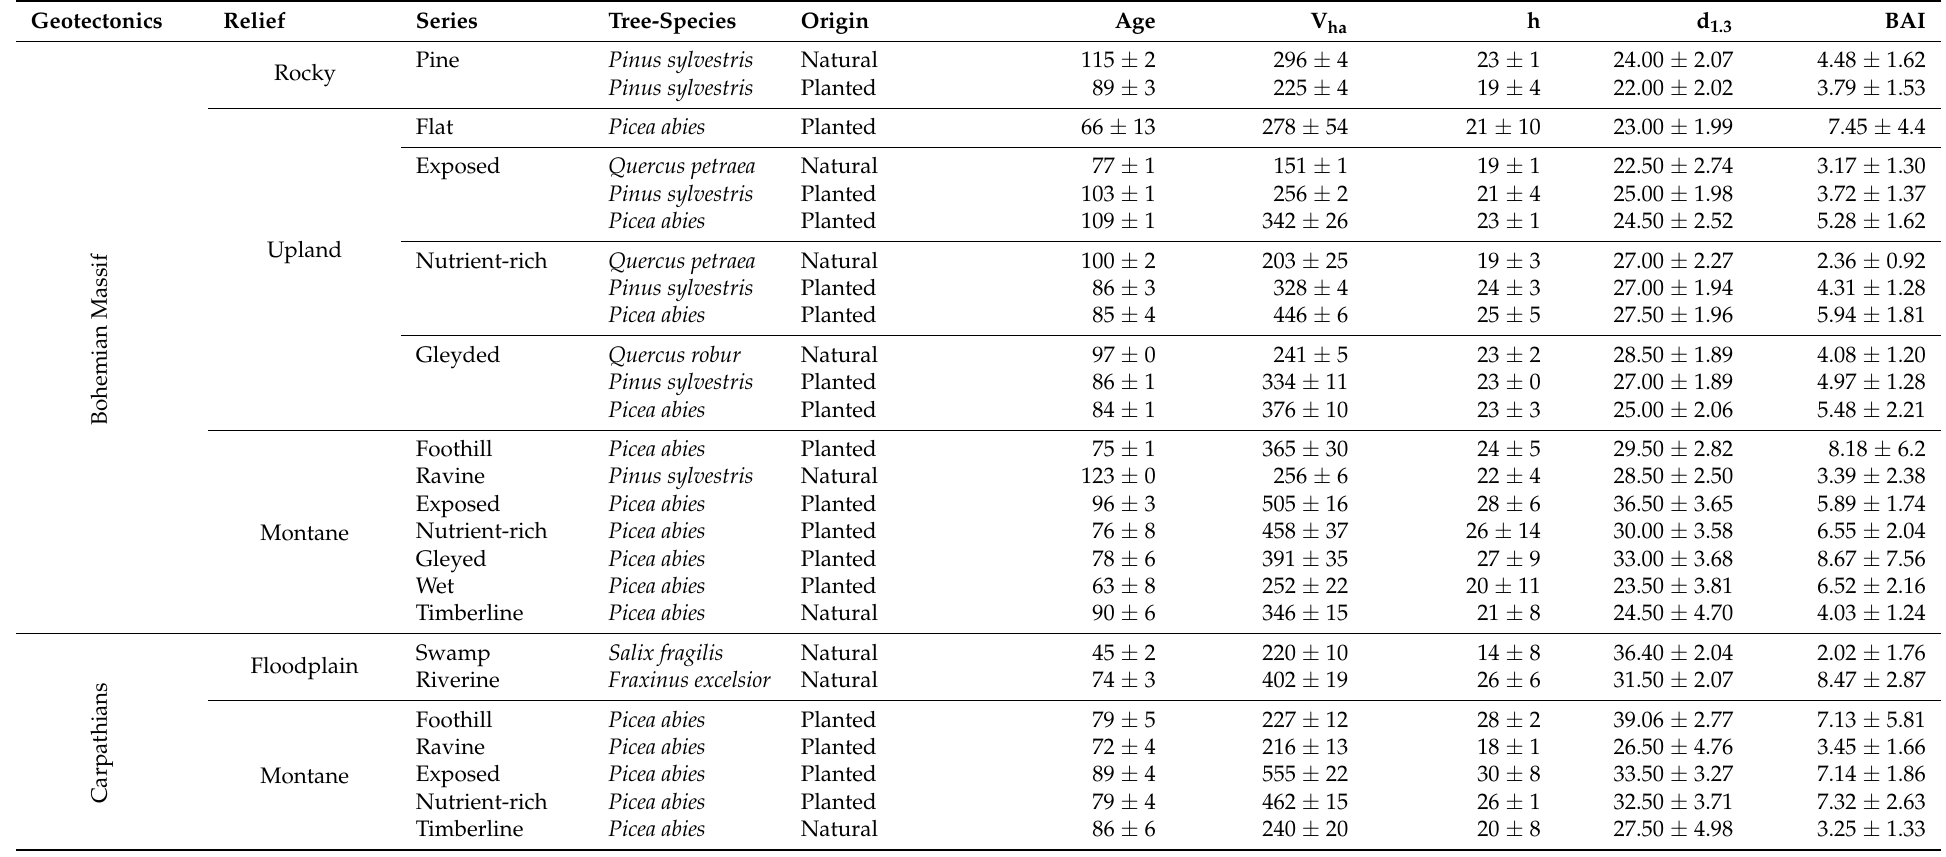
Table 4. Grow characteristics of sampled forest stand types (mean ± standard